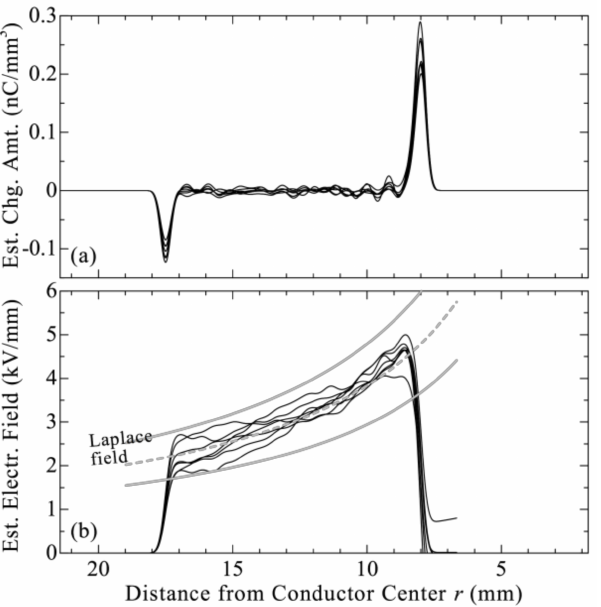
Figure 9. Examples of charge ( a ) and electric field distribution ( b ) estimated for several space charge data obtained by applying the DC voltage of V L . The gray curves in ( b ) represent the field curve calculated from Laplace’s equation. The 95.4% confidential interval area is also shown. These curves were extrapolated to the inner and outer conductive layer areas to increase